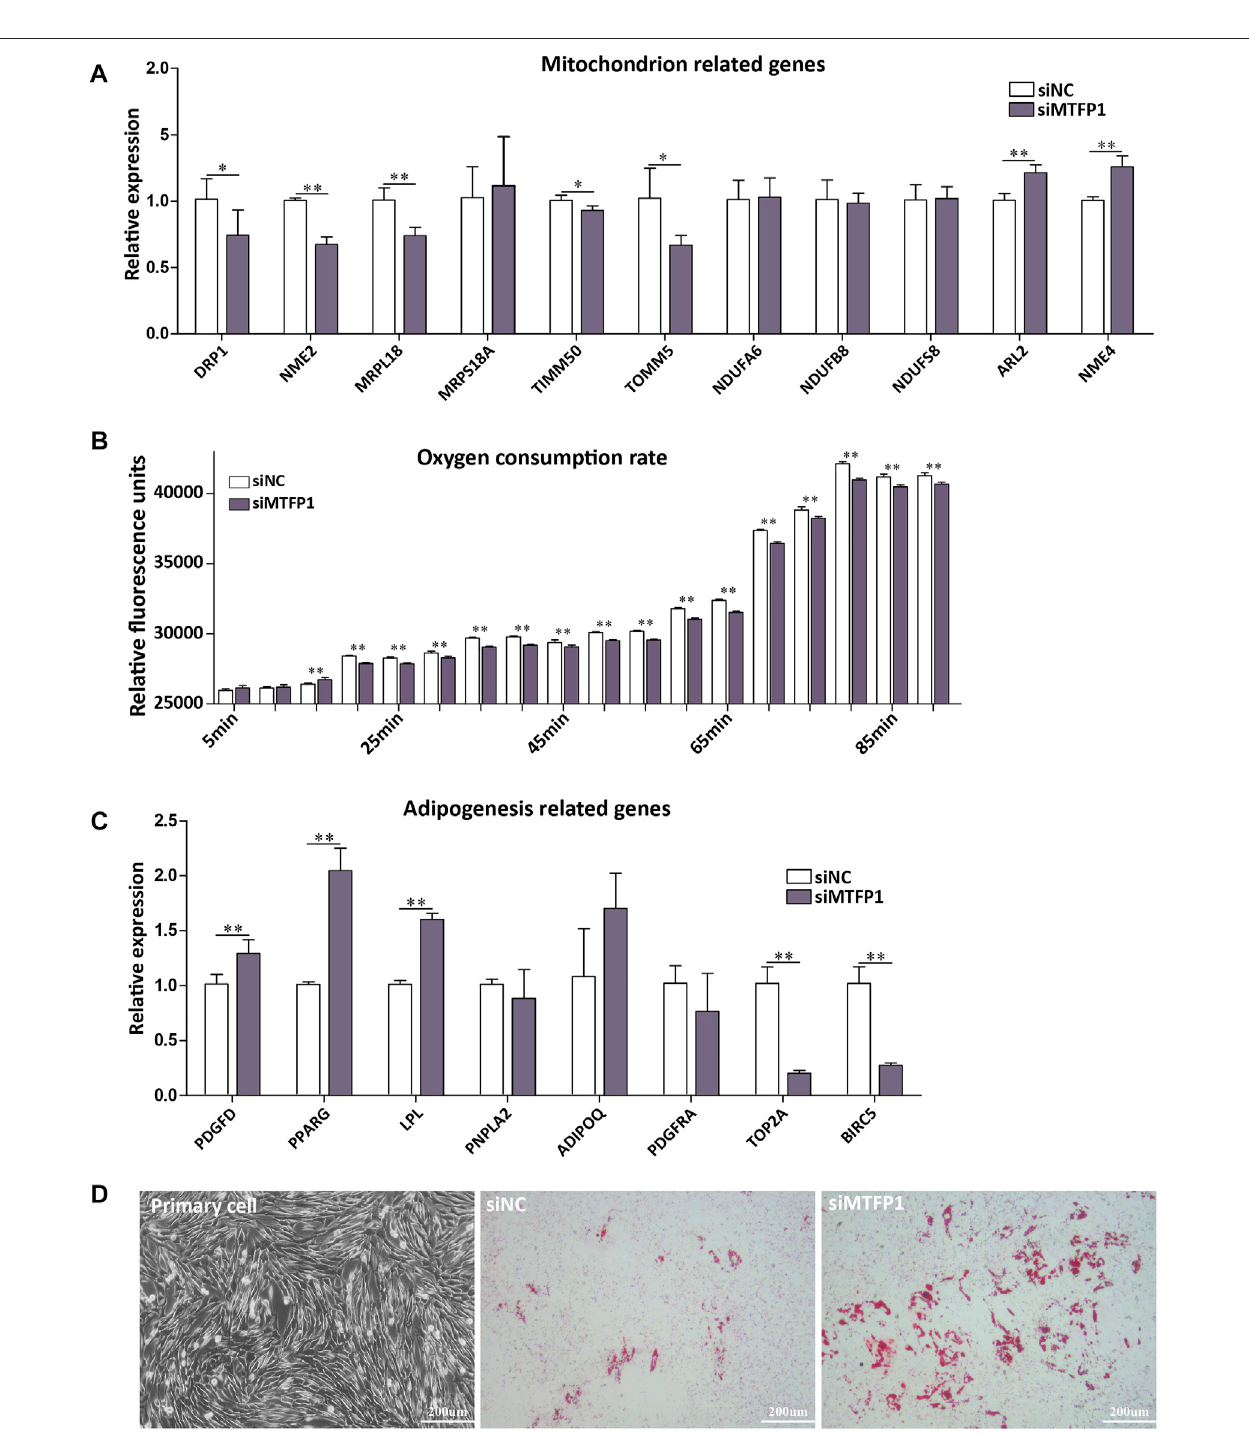
FIGURE 5 | (A) The effect of siRNA-induced MTFP1 knockdown on the expression of genes associated with mitochondrial function, including DRP1 , NME2 , MRPL18 , MRPS18A , TIMM50 , TOMM5 , NDUFA6 , NDUFB8 , NDUFS8 , ARL2 and NME4 . (B) Theeffect ofsiRNA-induced MTFP1 knockdownonoxygenconsumption within cell. The effect of siRNA-induced MTFP1 knockdown on the expression of genes associated with adipogenesis (C) , including: PDGFD , PPARG , LPL , PNPLA2 , ADIPOQ , PDGFRA , TOP2A and BIRC2 , as well as its effect on adipocyte differentiation in vitro (D) . Error bars represent mean ± SD. * p < 0.05, ** p < 0.01.